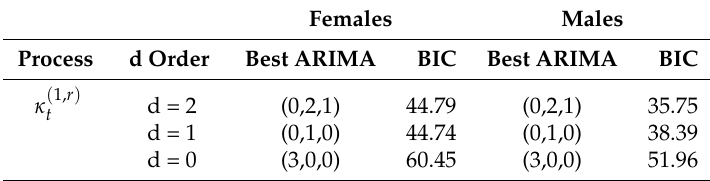
Table 9. BIC for different ARIMA processes for period effect in the RH model for the reference